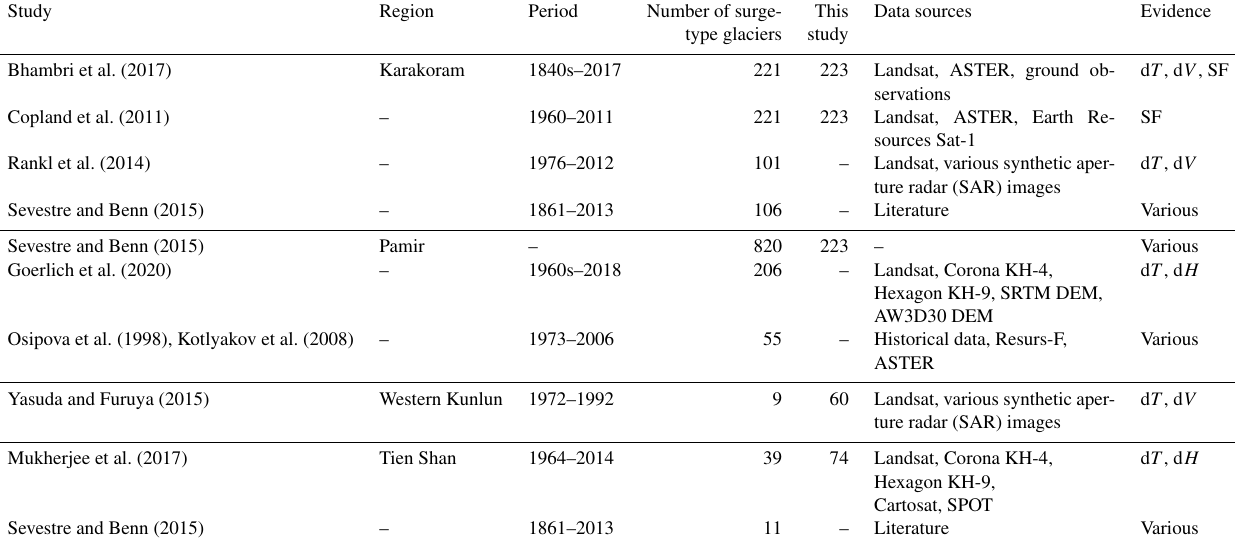
Table 4. Comparison of the number of surge-type glaciers identified by other inventory studies in sub-regions of HMA with our results. d T : change in terminus position; d V : changes in glacier surface velocity; SF: surface features; d H : changes in glacier surface